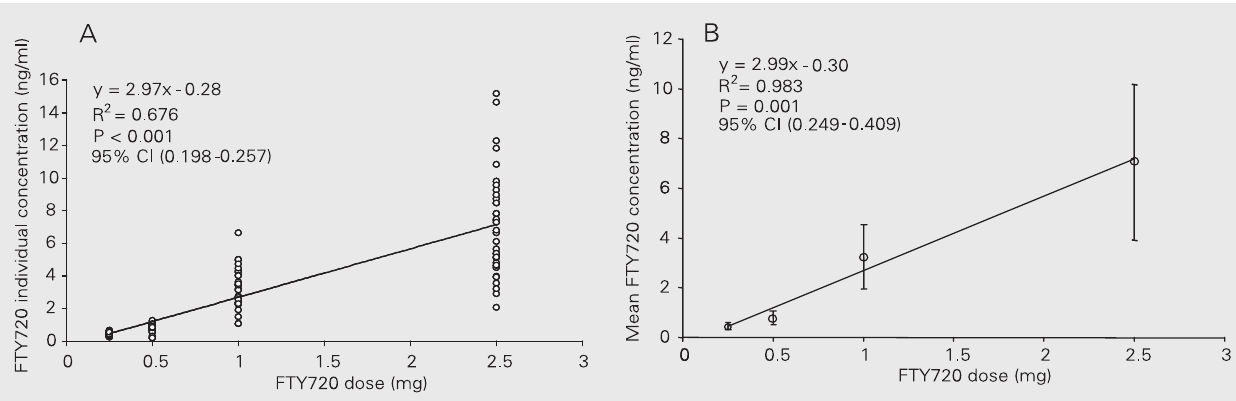
Figure 3. Linear regression analysis correlating individual (A) or mean (B) FTY720 blood concentrations and